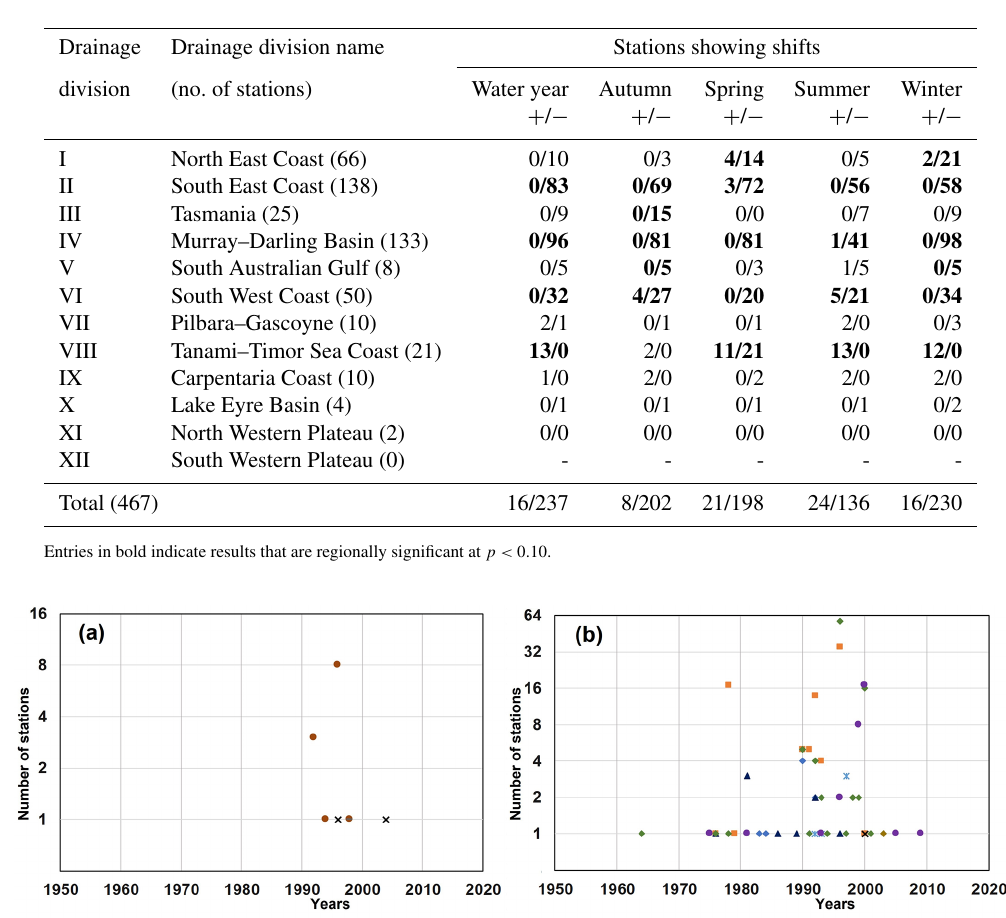
Table 5. Annual and seasonal shifts in different drainage divisions using a Pettitt test at p < 0 . 10. The numbers in each column represent the number of stations with increasing shifts (denoted using “ + ”) and the number of stations with decreasing shifts (denoted using “ − ”) separated by a slash.